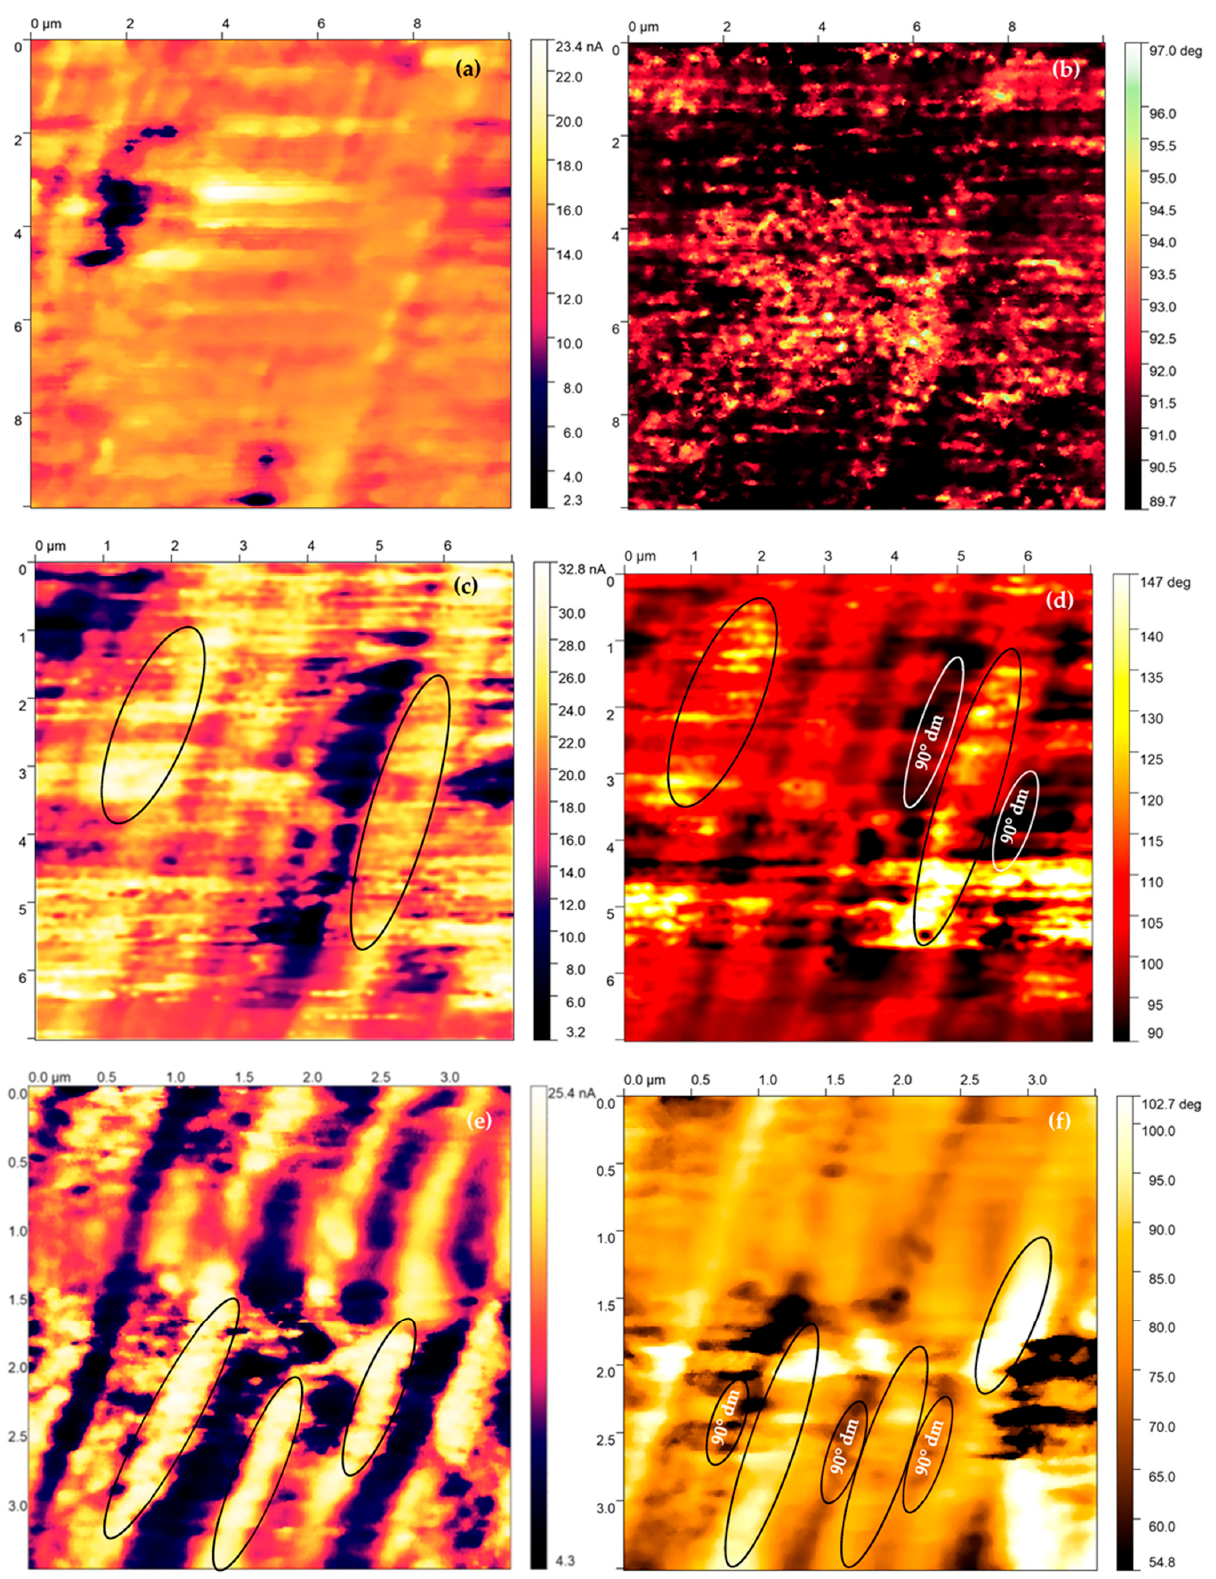
Figure 9. Current distribution and phase alignment for 0 V ( a , b ) − 8 V ( c , d ) 8 V ( e , f ) bias BFO 100 nm Pt/TiO2/Si.